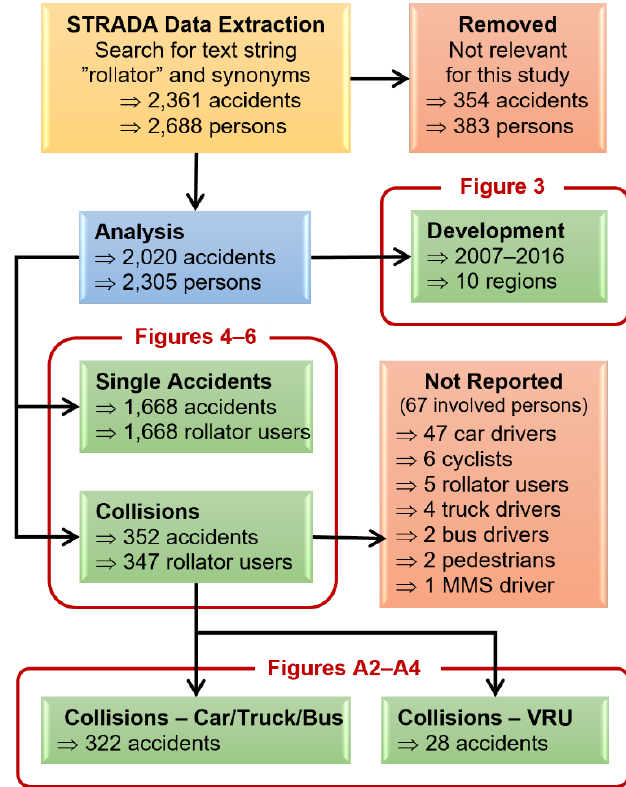
Figure 1. Schematic overview of performed data